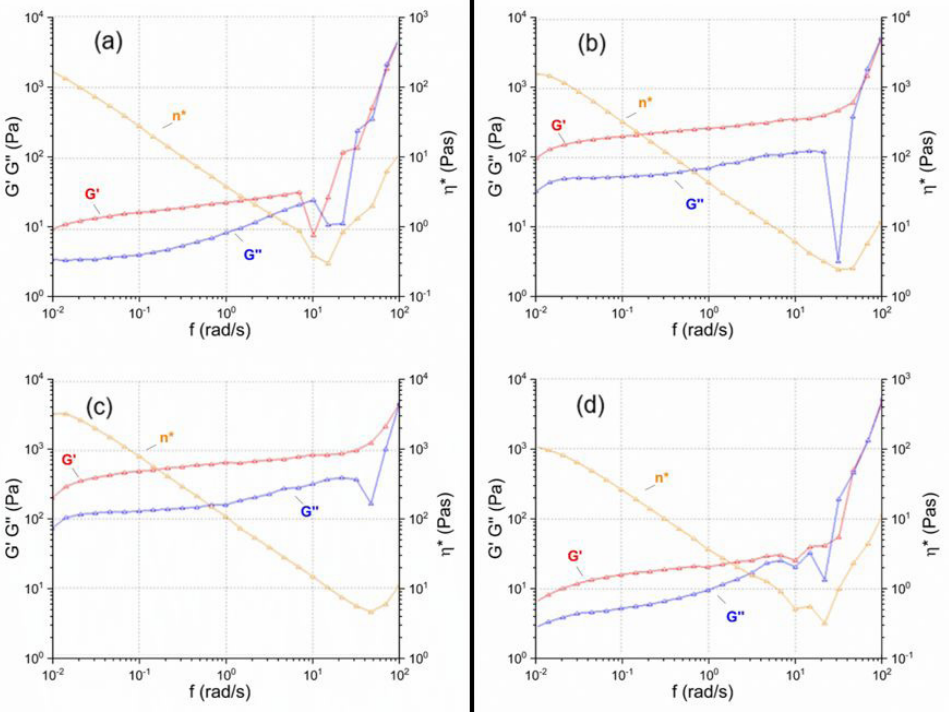
Figure 3. Frequency sweep curves (G’ versus frequency) of samples (a) 2A, (b) 3E, (c) 7SA and (d) 10NA. G’ in red, G’’ in blue, η* in